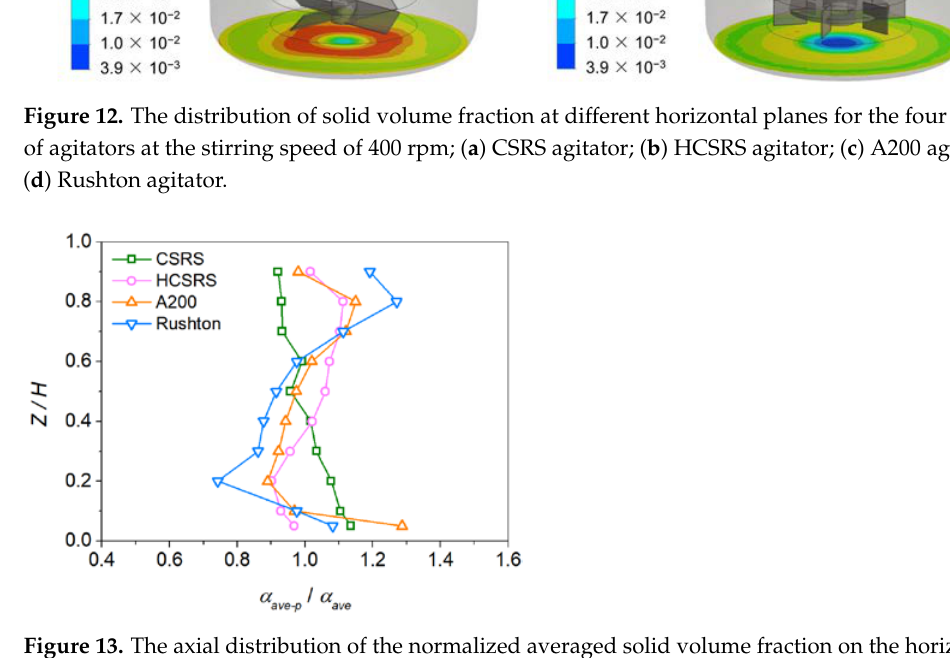
Figure 13. The axial distribution of the normalized averaged solid volume fraction on the horizontal planes ( α ave-p ) for the four types of agitators at the stirring speed of 400 rpm.